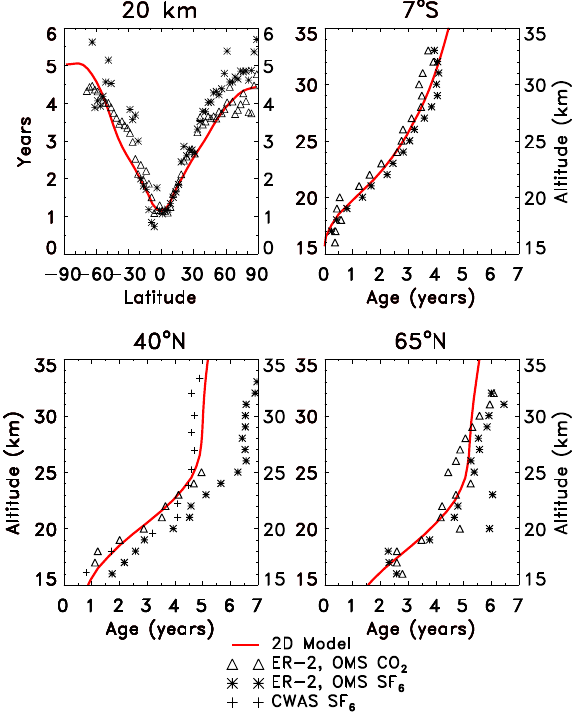
Figure B4. Age of air at 20km derived from ER-2 aircraft measurements of SF 6 (asterisks) and CO 2 Fig. B4. Age of air at 20km derived from ER-2 aircraft measure- (triangles), and vertical profiles of the age of air derived from balloon measurements of SF 6 (asterisks, ments of SF 6 (asterisks) and CO 2 (triangles), and vertical profiles plus signs) and CO 2 (triangles) at the latitudes indicated. Ages derived from these measurements have of the age of air derived from balloon measurements of SF 6 (aster- Fig. B5. Latitude-height cross-sections of September N 2 O aver- been adapted from Hall et al. (1999). Also shown are simulations from the 2-D model (red line). The 68 isks, plus signs) and CO 2 (triangles) at the latitudes indicated. Ages Figure B5. Latitude-height cross-sections of September N 2 O averaged over 2004–2009 from age is taken relative to the tropical tropopause. aged over 2004–2009 from AURA/MLS (top) and the 2-D model derived from these measurements have been adapted from Hall et AURA/MLS (top) and the 2-D model (bottom). Contour interval is 20 ppbv and includes the 10 ppbv (bottom). Contour interval is 20ppbv and includes the 10ppbv con- al. (1999). Also shown are simulations from the 2-D model av- contour. eraged over the 1990s (red line). The age is taken relative to the 69 tropical tropopause.